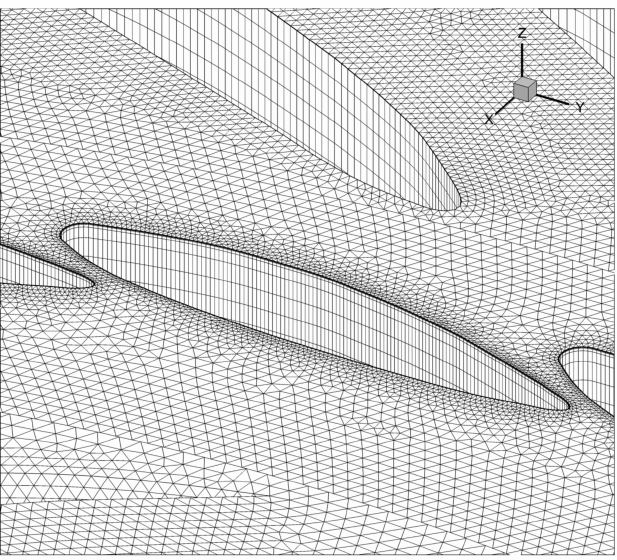
Figure 2. Mesh of the guide vane domain.